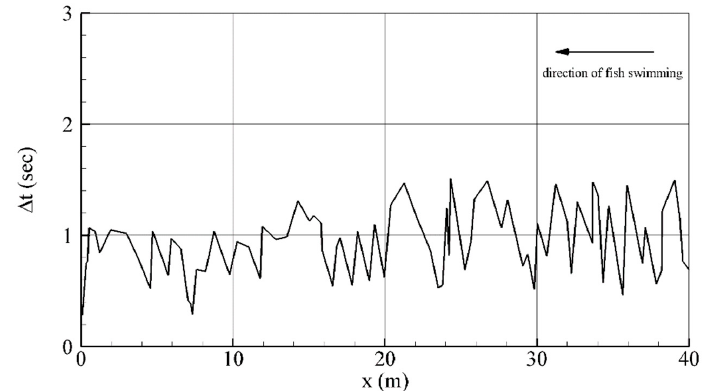
Figure 5. Dependence of time step ∆𝑡 versus the distance 𝑥 of fish movement for the original approach.